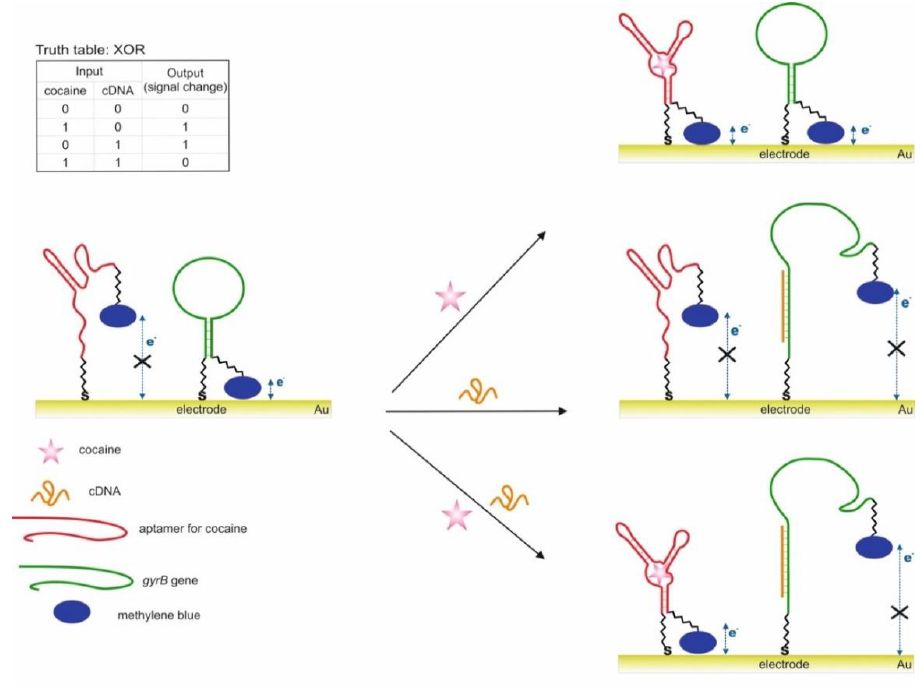
Figure 12. Logic gate XOR. Adapted from Reference [132]. Copyright © 2020, American Chemical